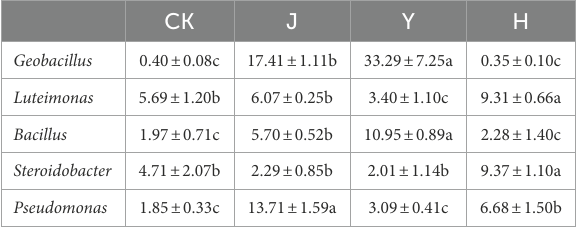
TABLE 11 Comparison of major bacterial community composition of soybean-potted rhizosphere soil at the genus